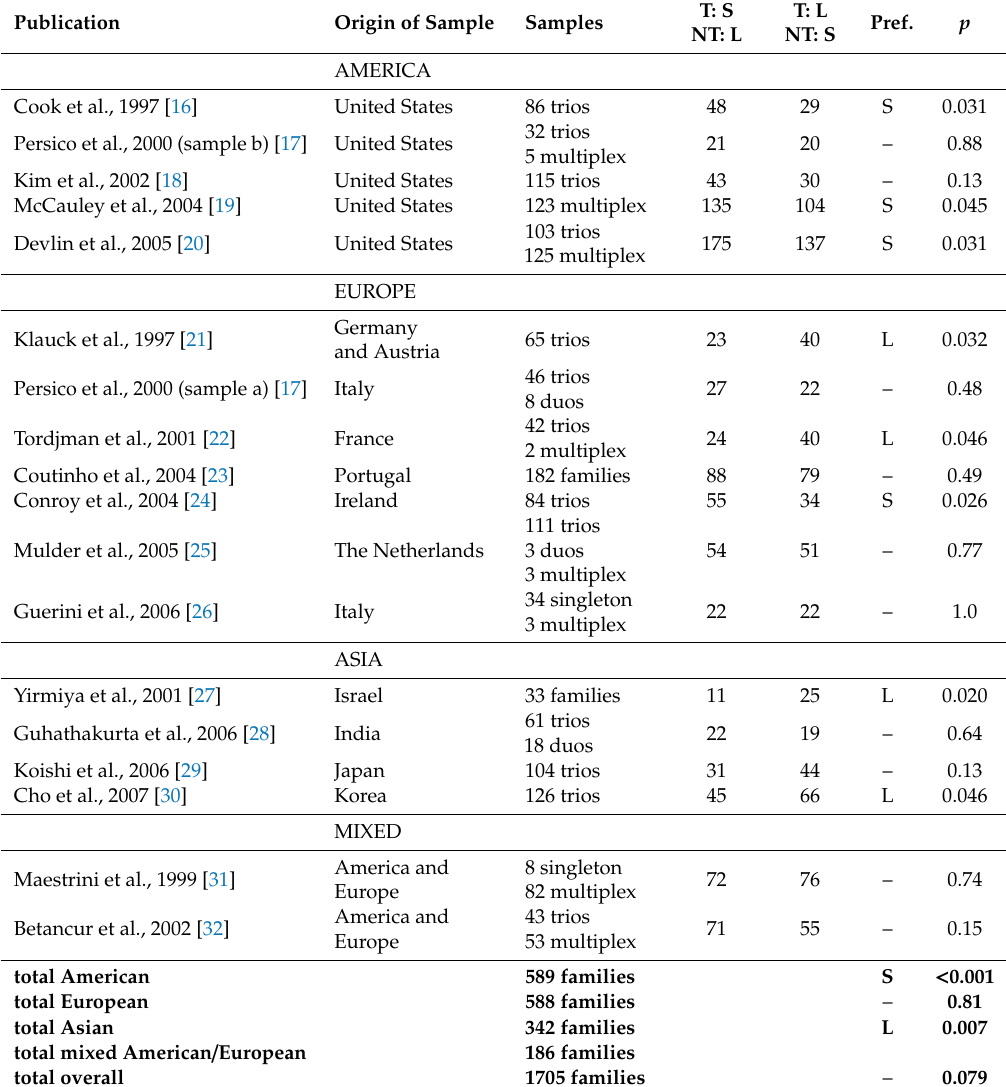
Table 1. Transmission disequilibrium test (TDT) studies on the genetic association between the short (S) and the long (L) 5-HTTLPR variant and autism spectrum disorder